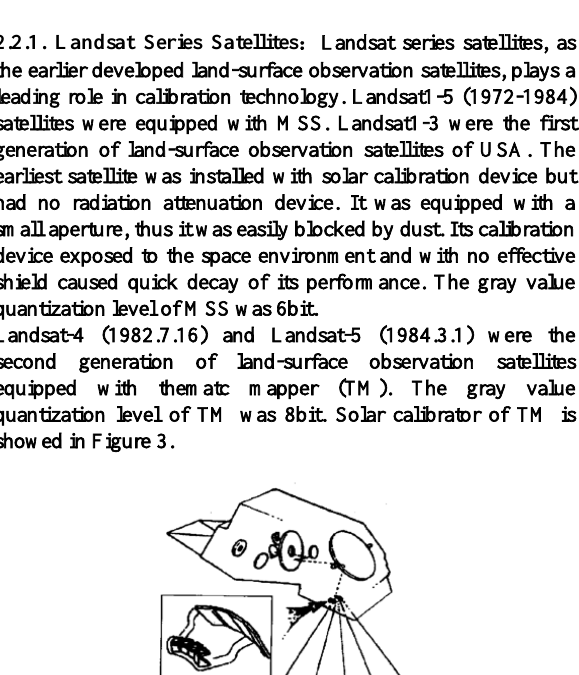
Figure 4. Configuration of ETM+ (http://directory.eoportal.org/) Landsat-8 (2013.2.11) satellite, the most advanced new- generation land satellite by far. It was equipped with the Operational Land Imager (OLI) (Figure 5) and Thermal Infrared Remote Sensor (TIRS) (Figure 6). Both of the two were push- broom sensors and their gray value quantization was 12bit (Geilman D I, 1993a) and (Patrice Henry, 2001a). The uncertainty of OLI radiometric calibration was less than 3% (D.P.Roy, 2014a).